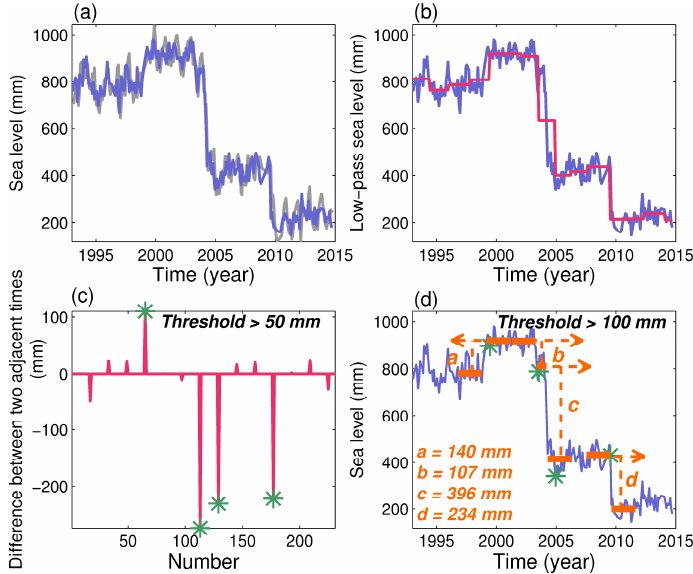
Figure 2. Detection of datum shifts in the monthly Kaohsiung tide gauge records. ( a ) original and deseasonal sea-level changes (original: gray line; deseasonal: purple line); ( b ) low-pass sea-levels based on the Haar multiresolution analysis (red line); ( c ) the differences between the two values in the adjacent times using the red line data in ( b ) (one month to the previous in each of the time series), the green stars are the suspected datum shifts (>50 mm); ( d ) the difference between the two averages that are calculated using the two-year records before and after the suspected datum shift.